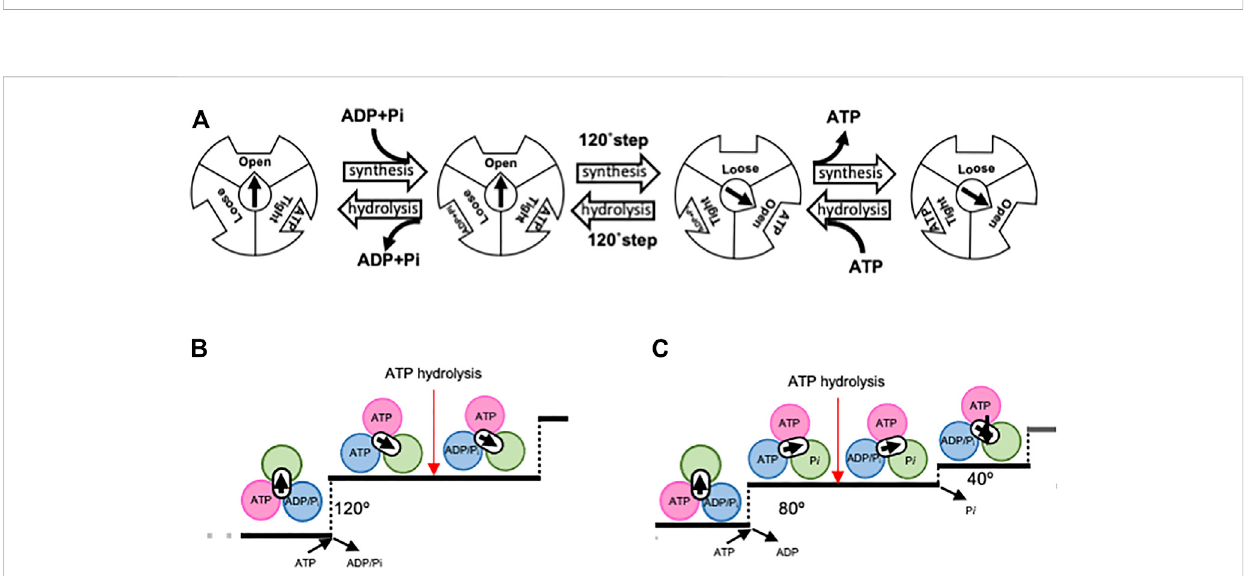
FIGURE 2 Proposed rotarymechanism of rotary ATPases. Boyer fi rst proposed amodel for thebinding-change mechanism (A) . Open , Loose , and Tight bonds correspond to α E β E , α D β D , and α T β T ,respectively. Thedirectionofsynthesis ischaracterized bythebindingofADP and Pito Loose ,followedbya120 ° step that results in Tight becoming Open and the release of ATP. Through the conversion of Loose to Tight , ADP is phosphorylated on Tight to form ATP. The reverse sequence of events occurred in the direction of ATP hydrolysis. Proposed chemo-mechanical cycles of V 1 -ATPase (B) and F 1 -ATPase (C) . Each image was viewed from the V 1 /F 1 side. In V 1 -ATPase, ATP binding results in a 120 ° rotation of the DF, followed by ATP hydrolysis. In contrast, F 1 - ATPase has been proposed to operate according to a model in which ATP binding initiates an 80 ° rotation, followed by ATP hydrolysis and Pi release, leading to a further 80 °